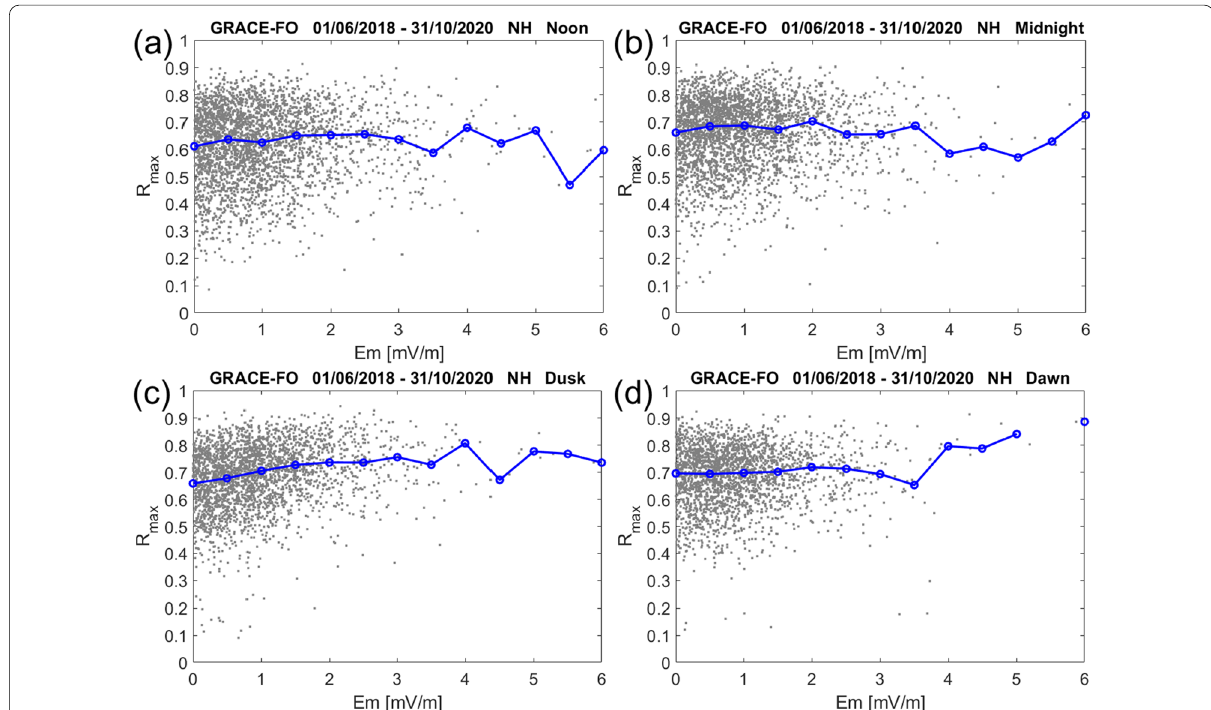
Fig. 8 Distribution of R max on magnetic activity (represented by the solar wind merging electric field, E m ), separately for different MLT sectors. Here we only present the results in the northern hemisphere, as it is similar in the southern